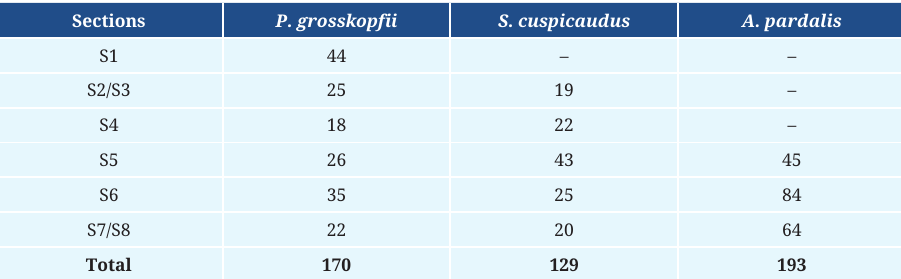
TABLE 1 | Number of individuals of Pimelodus grosskopfii , Sorubim cuspicaudus , and Ageneiosus pardalis analyzed in the middle and lower basin of the Cauca River. S1–S4: Middle section of the Cauca River, S1 and S2–S4 are located upstream and downstream of the construction zone of the dam, respectively. S5–S8: Lower section of the Cauca Sections